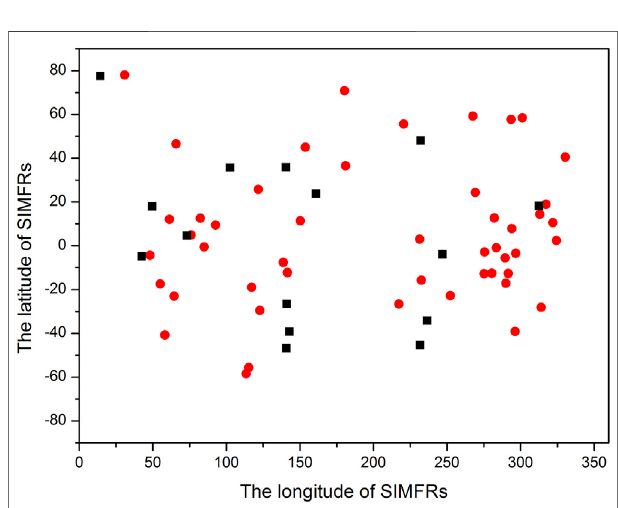
FIGURE 4 | The distribution of the latitude and longitude of the axial direction of the studied SIMFRs. The red dots represent cases that the SIMFRs quasi-parallel to the associated HCS (CAT1). The black squares represent the SMIFRs of CAT2 category.